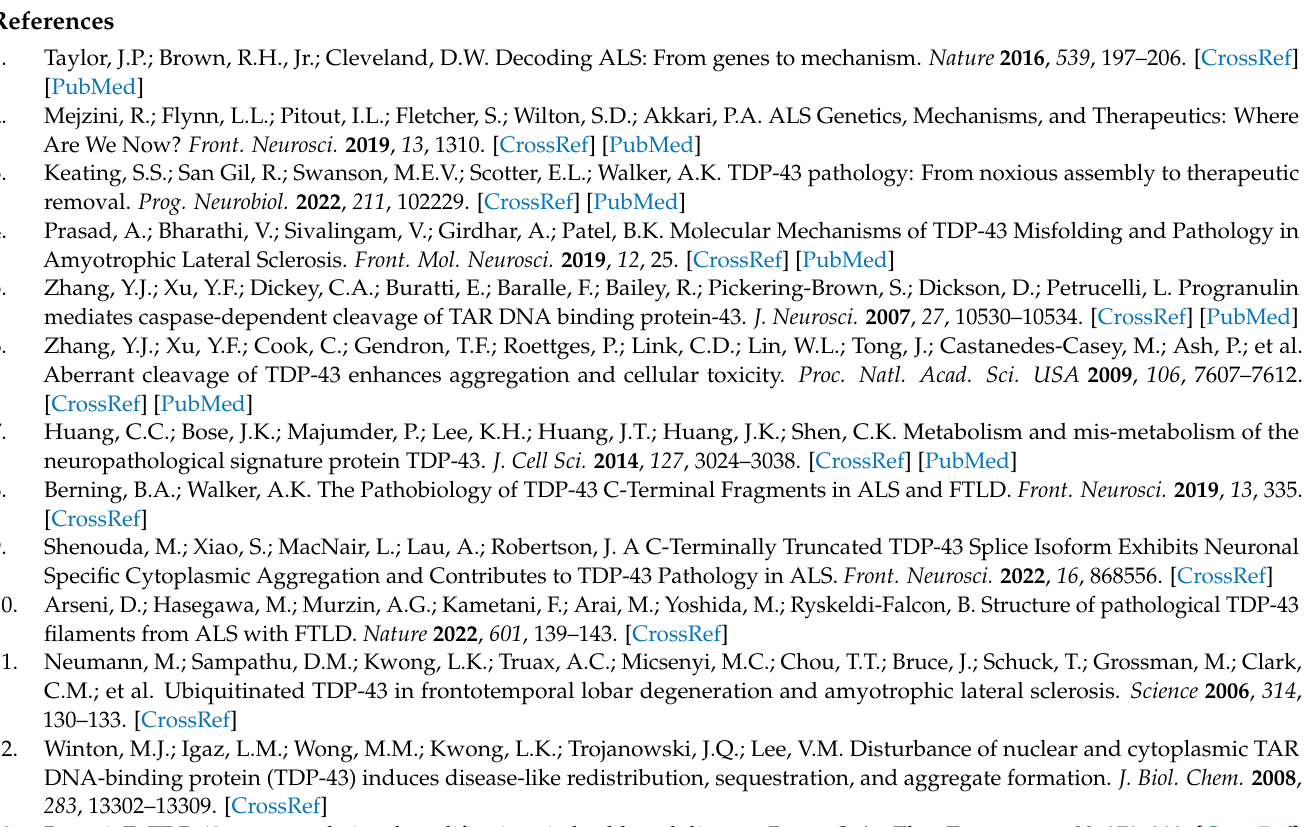
Figure S4: Simultaneous expression of the LUBAC subunits, Figure S5: Construction of doxycycline (Dox)-inducible truncated TDP-43-expressing Neuro2a cells, Figure S6: HOIPIN-8 suppresses the increased NF- κ B activity by truncated TDP-43 in HEK293T